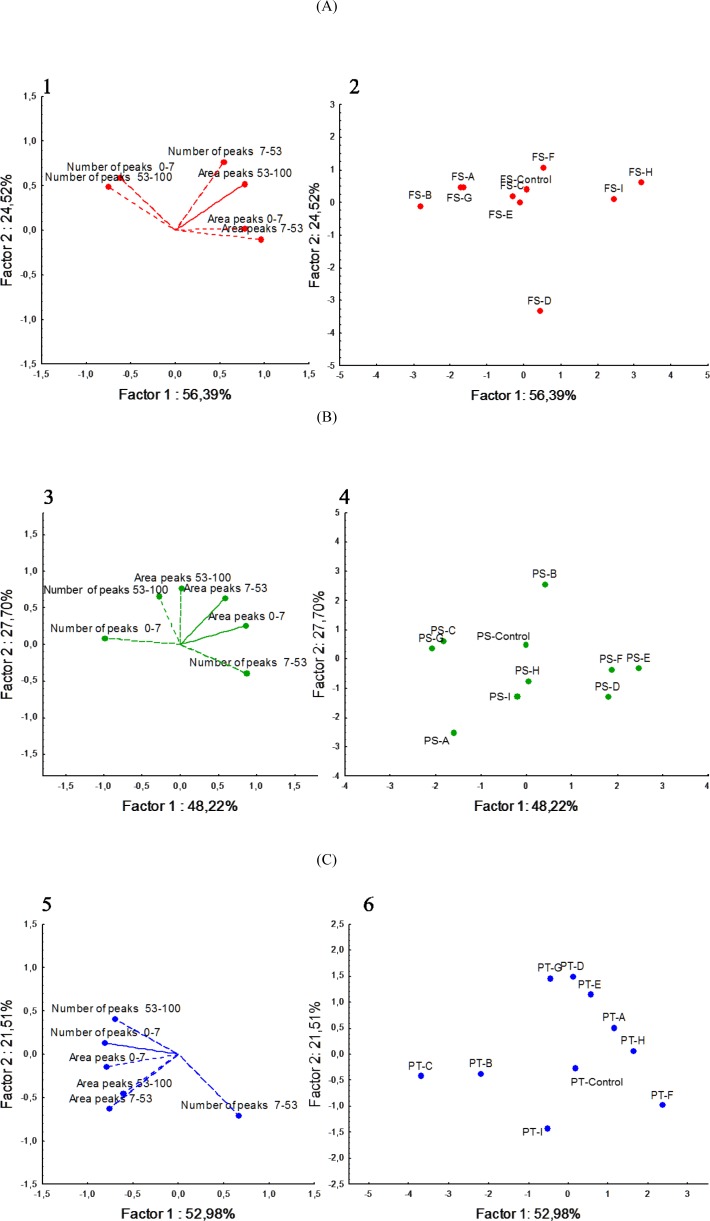
Score plot and loading plot of the first and secondary principal components based on area and number peaks obtained from reverse phase high pressure liquid chromatography (RP-HPLC).Score plot and loading plot (panels 1, 3, 5) of the first and secondary principal components (PC) (panels 2, 4, 6) after PC analysis based on area and number peaks obtained from reversed-phase high-protein liquid chromatograms of the pH 4.6-soluble fractions of Fiore Sardo (A), Pecorino Siciliano (B) and Pecorino Toscano (C). Nine sub-blocks are identified by the letters A—I. Sub-blocks A, D, and G, and sub-blocks C, F and I were collected from top and bottom surface region, respectively, whereas sub-blocks B and H from inner side region, and sub-block E from the core. The whole slice was the control Control. Further details were reported in the Material and Methods and in Fig 1.